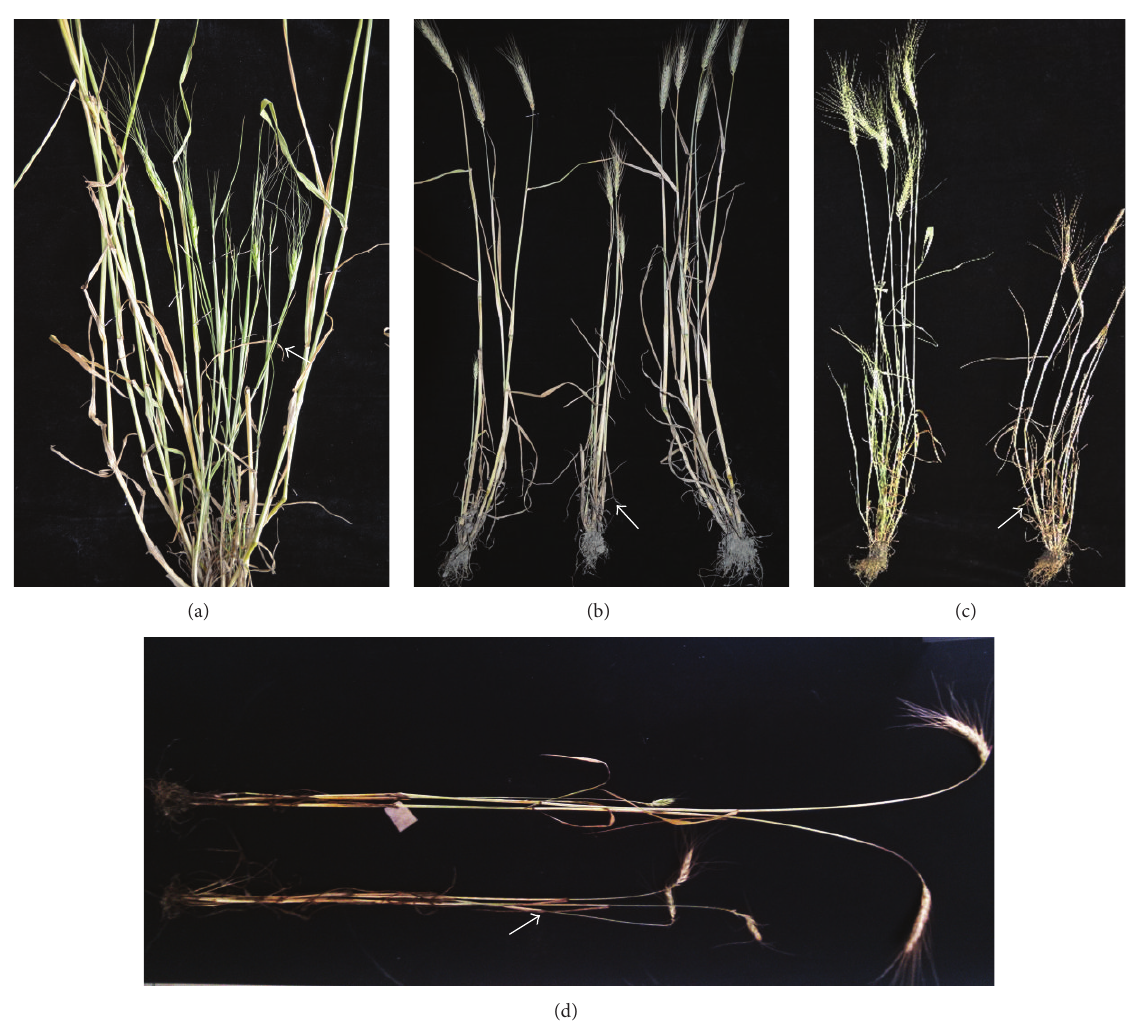
Figure 1: The special agronomic characters of the materials under radiation treatment. (a) T. dicoccoides (As838) 239-7, with 11 secondary tillerings and the after stalk with wax powder (arrowed), (b) T. turgidum (As2255) 253-10, dwarf (arrowed), (c) T. carthlicum (As293) 250-1, plant senescence (arrowed), and (d) T. polonicum (As302) 224-14, dwarf (arrowed).